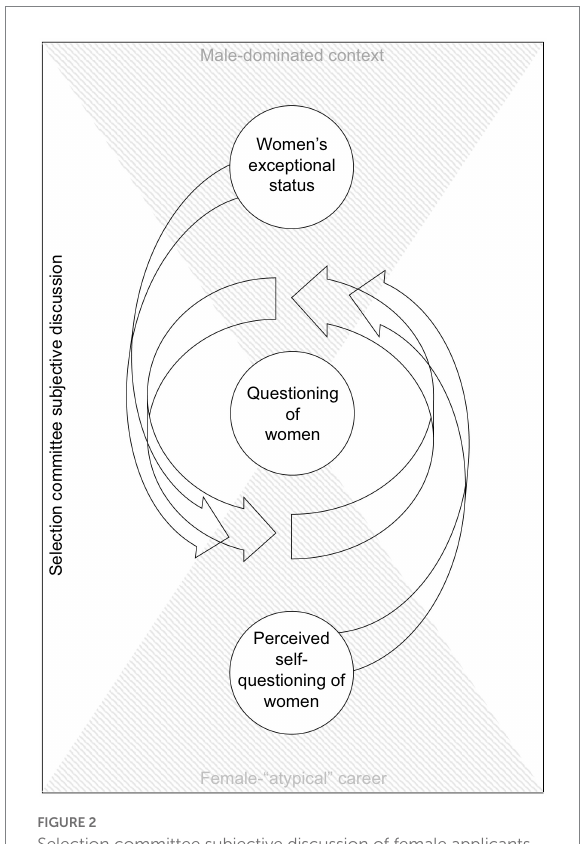
FIGURE 2 Selection committee subjective discussion of female